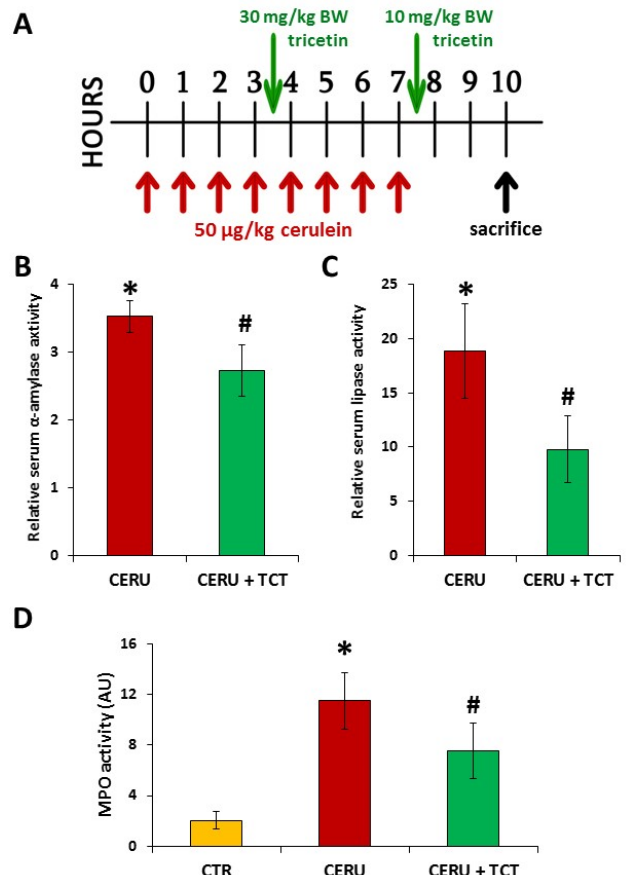
Figure 7. Posttreatment with tricetin inhibits tissue injury and inflammatory cell migration in acute pancreatitis. Acute pancreatitis was induced in mice with (8 × 50 μ g/kg BW, i.p.) cerulein treatment at hourly intervals. The animals were sacrificed 10 h after the first cerulein injection. Tricetin (TCT) was administered between the 4th and 5th cerulein injections (30 mg/kg BW, i.p.) and after the last cerulein injection (10 mg/kg BW) ( A ). Serum levels of amylase and lipase were measured. Cerulein treatment significantly elevated serum α -amylase and lipase levels. This elevation in serum α -amylase and lipase levels was attenuated by TCT posttreatment ( B , C ). TCT suppressed neutrophil infiltration in the pancreas as indicated by the decreased tissue MPO levels ( D ). Error bars represent SD of six mice. Statistical analysis was performed with one-way ANOVA test followed by Tukey’s post hoc test. Stars (*) indicate significant ( p < 0.05) differences between cerulein-treated and control groups. Hashtags (#) indicate significantly ( p < 0.05) reduced values in the TCT group versus the cerulein-treated group.